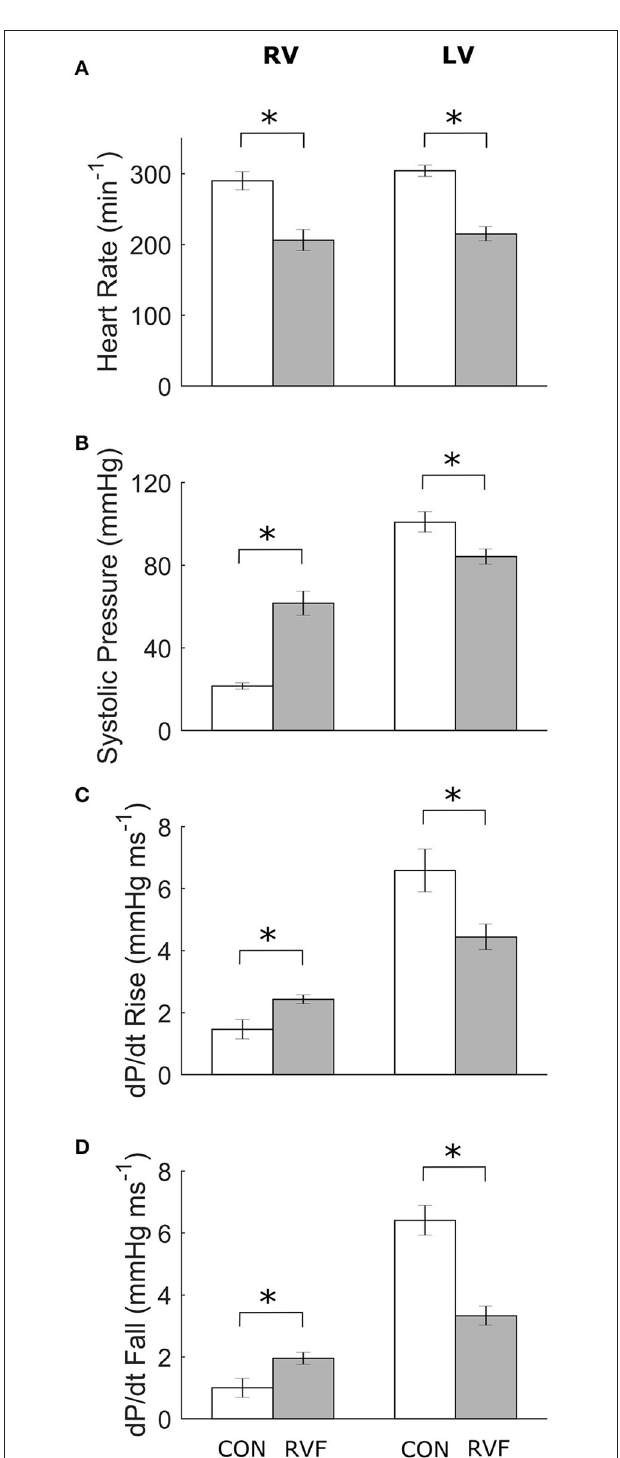
FIGURE 2 | Mean ± SE in vivo heart rates and pressure of the ventricles of control and right-ventricular failing rats at Week 6. Data obtained from the right ventricle (4 Control and 5 RVF rats) and the left ventricle (5 Control and 7 RVF rats). Significant differences (* P < 0.05) between rat groups were observed in heart rate (A) , systolic ventricular pressure (B) , and the rates of rise (C) and fall (D) of ventricular pressure.